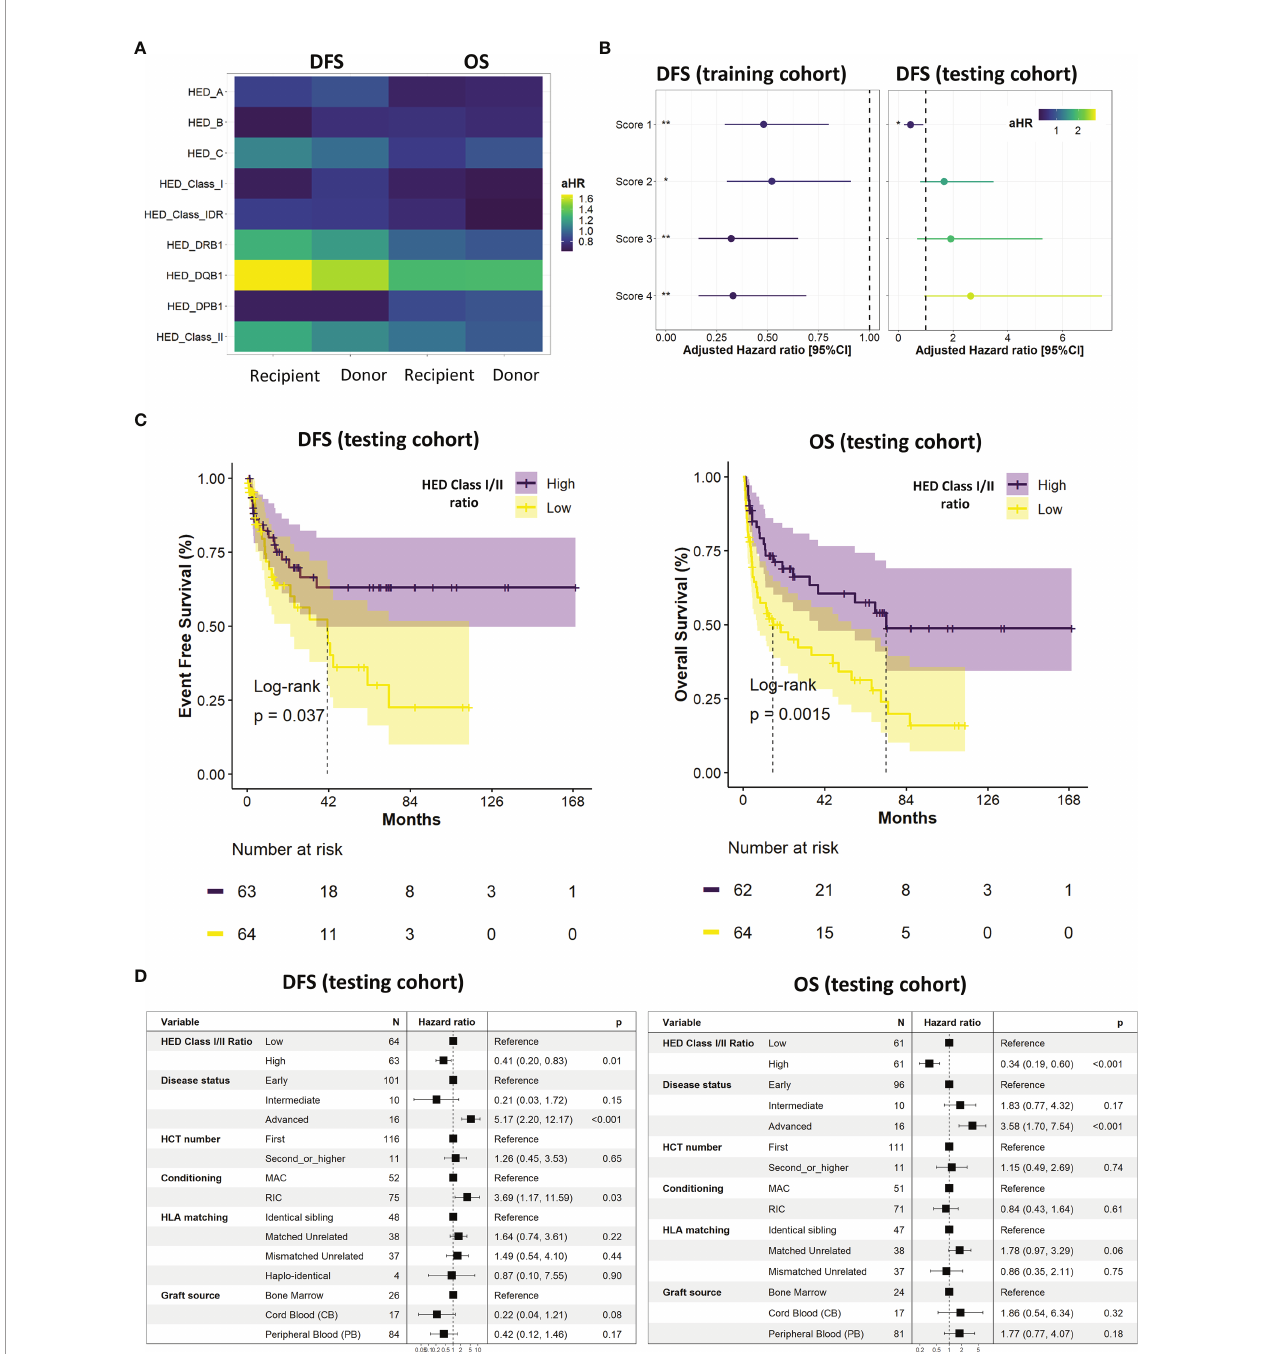
FIGURE 2 | Survival analyses and ratio establishment. (A) Impact of individual allele HED on overall (OS) and disease-free (DFS) survival for both recipients and donors. Adjusted hazard ratio (HR) were calculated using a multivariate cox model controlling for disease status, HCT number, conditioning, use of total body irradiation, HLA matching, and graft source. (B) Evaluation of the impact on DFS of the four established scores in the training (left) and testing (right) cohorts. Adjusted HR were calculated using a multivariate cox model controlling for disease status, HCT number, conditioning, use of total body irradiation, HLA matching, and graft source. FDR-adjusted p-values signi fi cance is represented (*: < 0.05, **: < 0.01, ***: < 0.001). (C) Kaplan Meier curves of DFS (left) and OS (right) according to the median class I/class II HED ratio (score 1) in the testing cohort. (D) Final multivariate cox models of DFS (left) and OS (right) according to the median class I/ class II HED ratio (score 1), disease status, HCT number, conditioning, HLA matching, and graft source in the testing cohort. A non-adjusted p-value cutoff of 0.01 was considered for signi fi cancy in the fi nal multivariate model. DFS, disease free survival; HED, HLA evolutionary divergence; CI, con fi dence interval; HCT, hematopoietic cell transplantation; HLA, Human leukocyte antigens; HR, hazard ratio; OS, overall